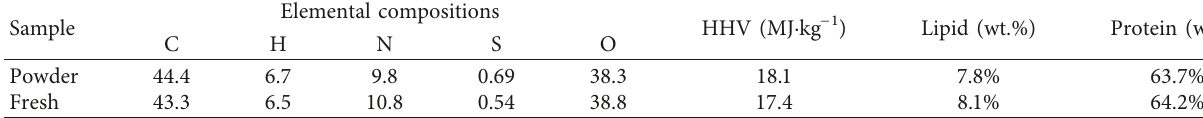
Table 1: Elemental analysis and HHV estimate.